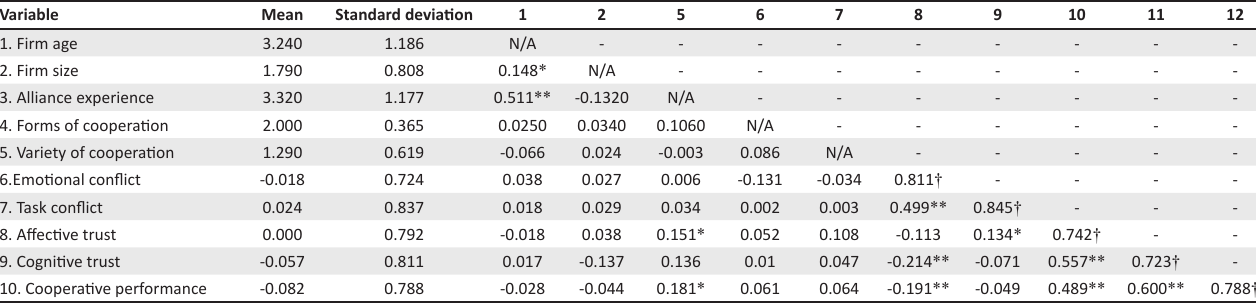
TABLE 2: Correlation coefficients and average variance extracted